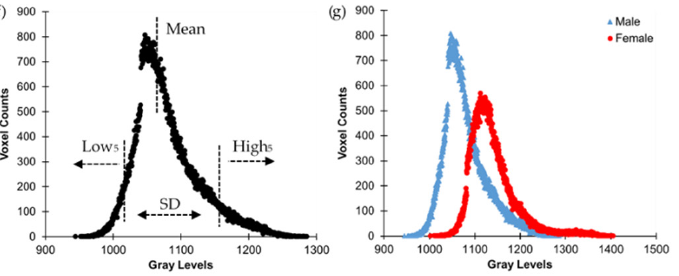
Figure 2. ( a ) Digital isolating process of C2 and C3 in 3D CBCT images for ( b ) the mid-sagittal CBCT slide views for ( c ) C2 and ( d ) C3 to measure (1) C2 height, (2) C2 width, (3) C2 concavity, (4) C3 top width, (5) C3 bottom width, (6) C3 anterior height, (7) C3 posterior height, and (8) C3 concavity. ( e ) Heterogeneity of gray levels, ( f ) a typical gray level histogram with gray level parameters, and ( g ) a comparison of the histograms between male and female. Male had higher voxel counts (i.e., volume) and female had higher gray levels (i.e., BMD